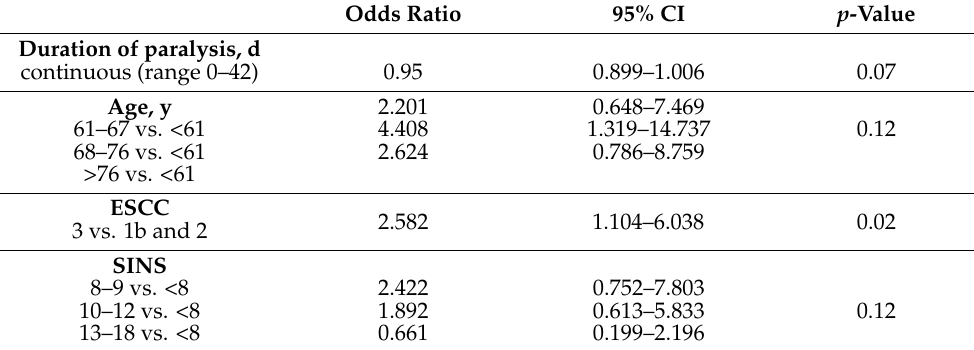
Table 5. Multivariate logistic regression